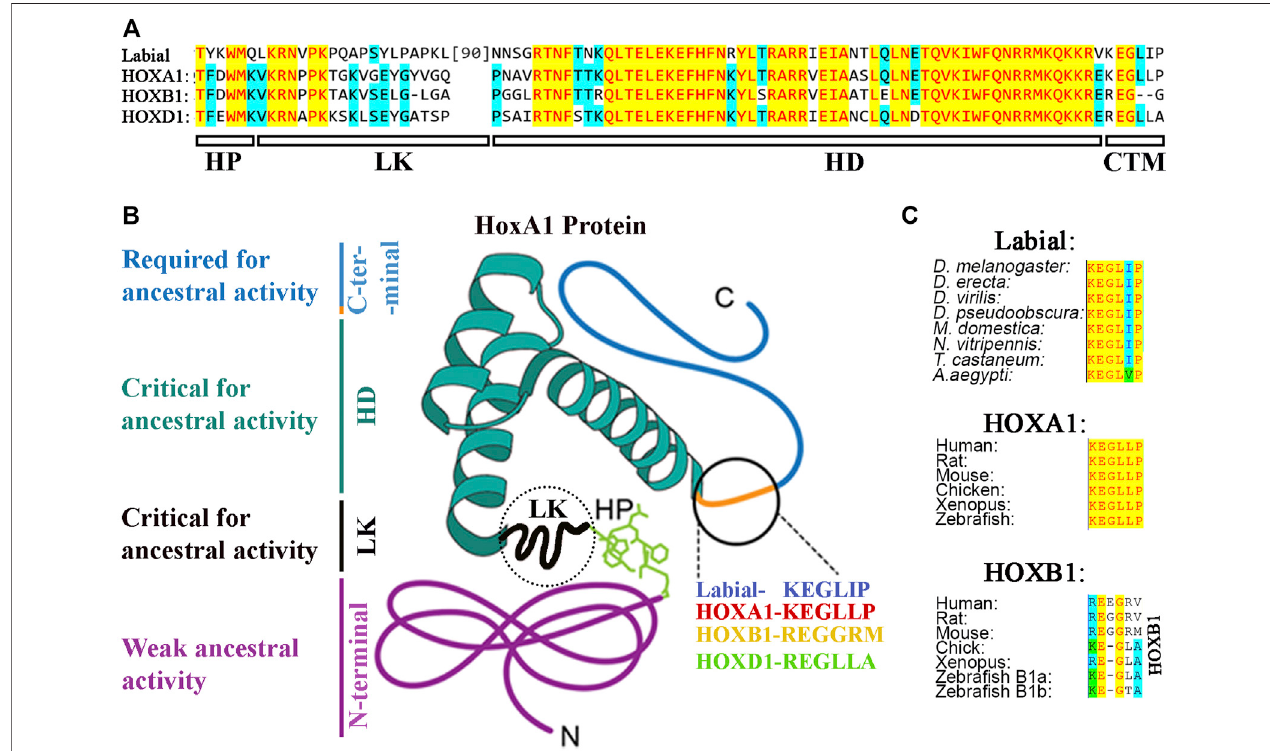
FIGURE 4 | (A) Protein sequence alignment of hexapeptide (HP), linker (LK), Homeodomain (HD) and CTM region of Drosophila Labial with that of mouse HOX1 paralogs. (B) Distribution of ancestral activity in HOXA1 protein. (C) Alignment of CTM region in arthropod Labial, vertebrate HOXA1 and HOXB1.